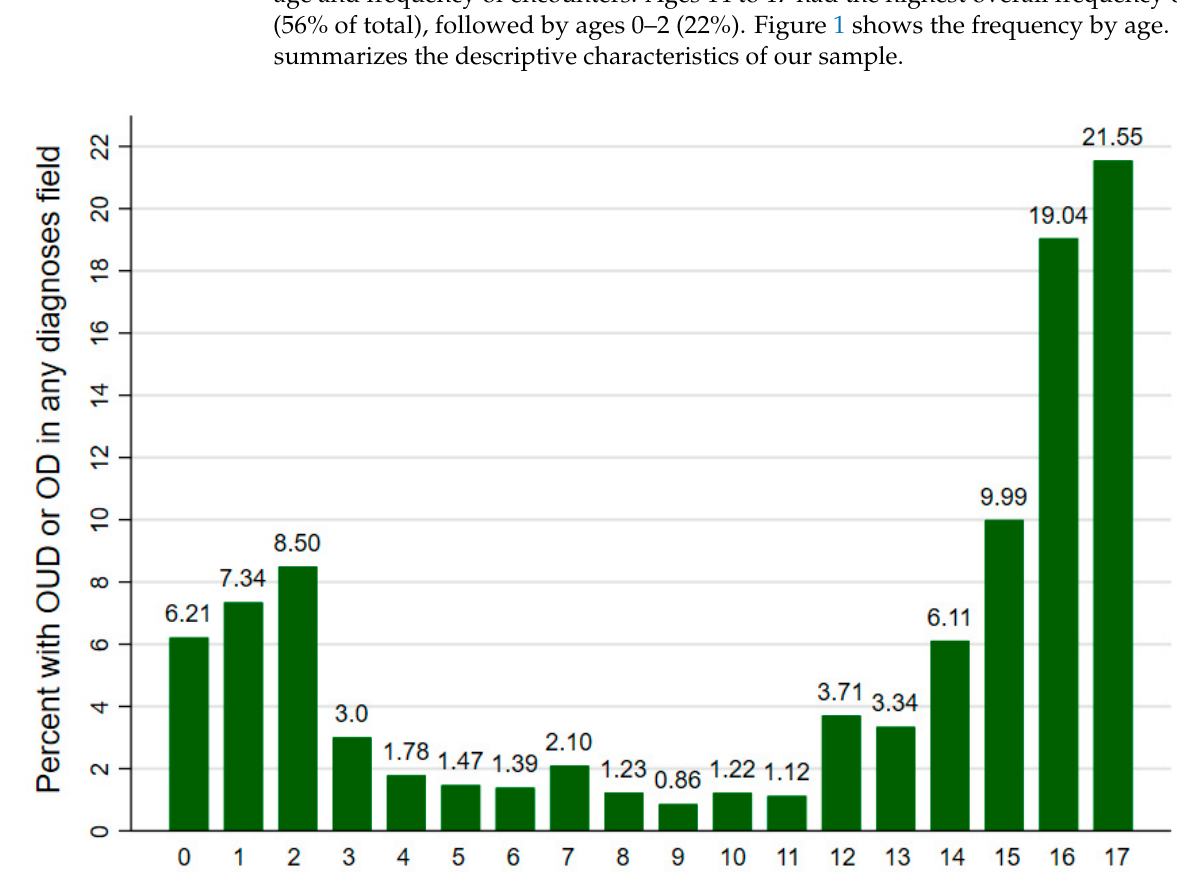
Figure 1. Age at visit to emergency department, all pediatric opioid-related cases, 2014–2017. Source: NEDS 2014–2017.